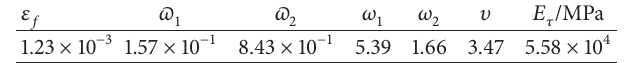
Table 5: Simulation values of the constitutive parameters. 𝜀 𝑓